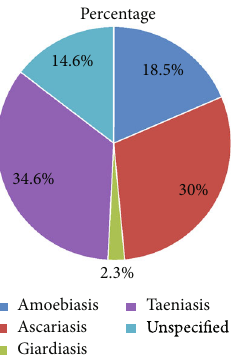
Figure 8: Proportion of intestinal parasite infections treated by medicinal plants in